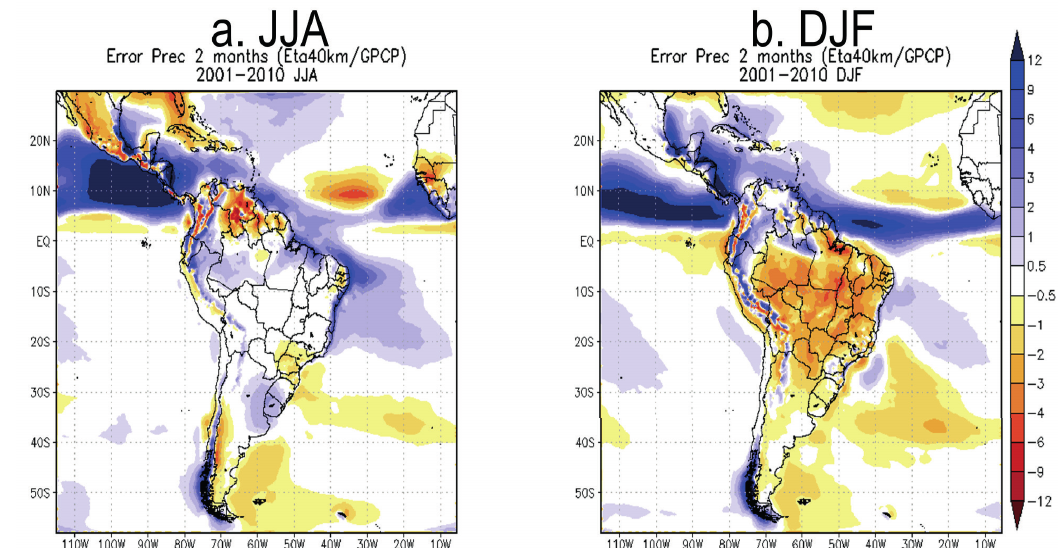
Figure 4. Eta RCM seasonal precipitation forecast errors (mm day -1 ) for (a) JJA and (b) DJF, from the two-month lead